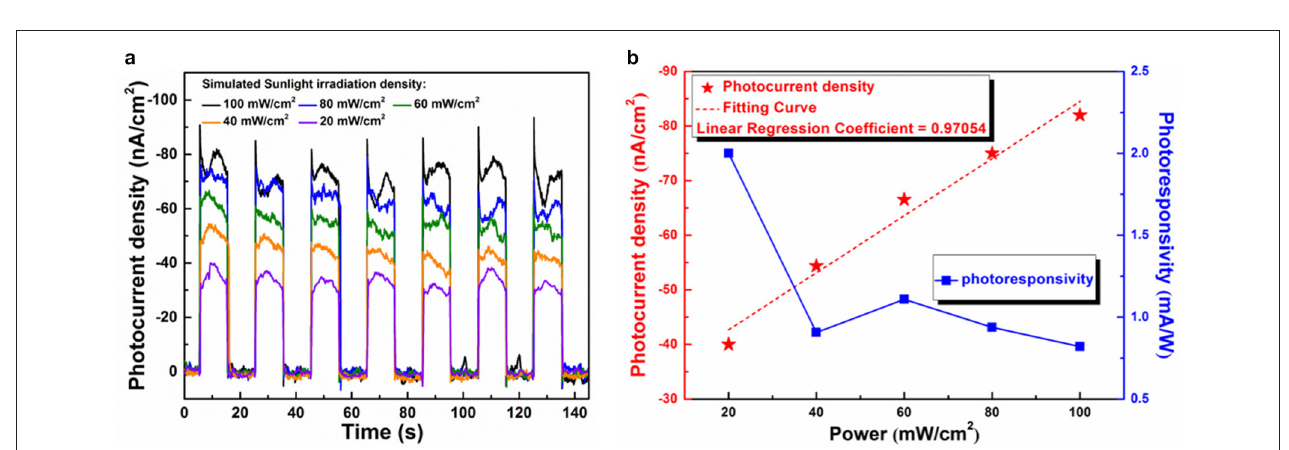
FIGURE 4 | (a) Photocurrent density of printed galinstan PEC device under different power intensity at 0V bias potential (20 mW · cm − 2 , 40 mW · cm − 2 , 60 mW · cm − 2 , 80 mW · cm − 2 , 100 mW · cm − 2 ). (b) Photocurrent density and calculated responsivity as a function of the power intensity at 0V bias potential.